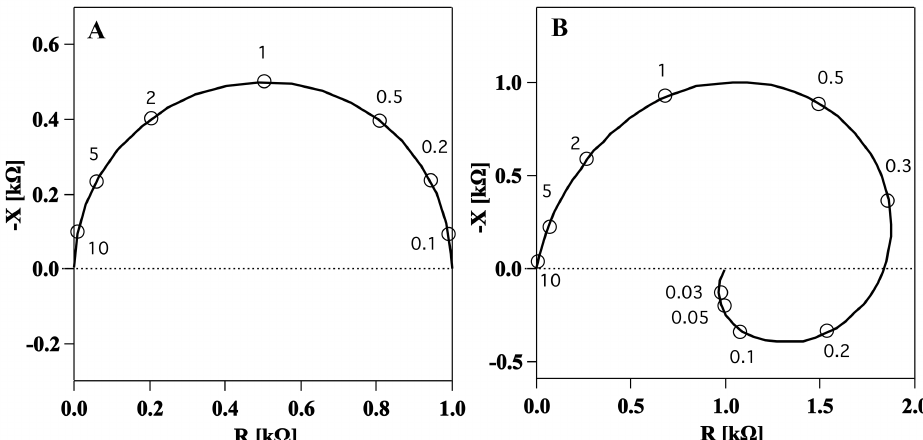
Figure 2. Longitudinal impedance data shown in a complex plot (Nyquist plot) showing the negative of the imaginary part (y axis) and the real part (x axis) of the impedance for different values of the frequency (open circles). ( A ). Calculated impedance spectrum of ideal capacitance resistance membrane like the one in Figure 1A. Frequencies are given in multiples of the characteristic frequency. ( B ). Measured impedance data for squid giant axon membrane in a frequency range from 10 kHz down to 30 Hz indicating an inductive element in the electrical circuit. Figures adapted from